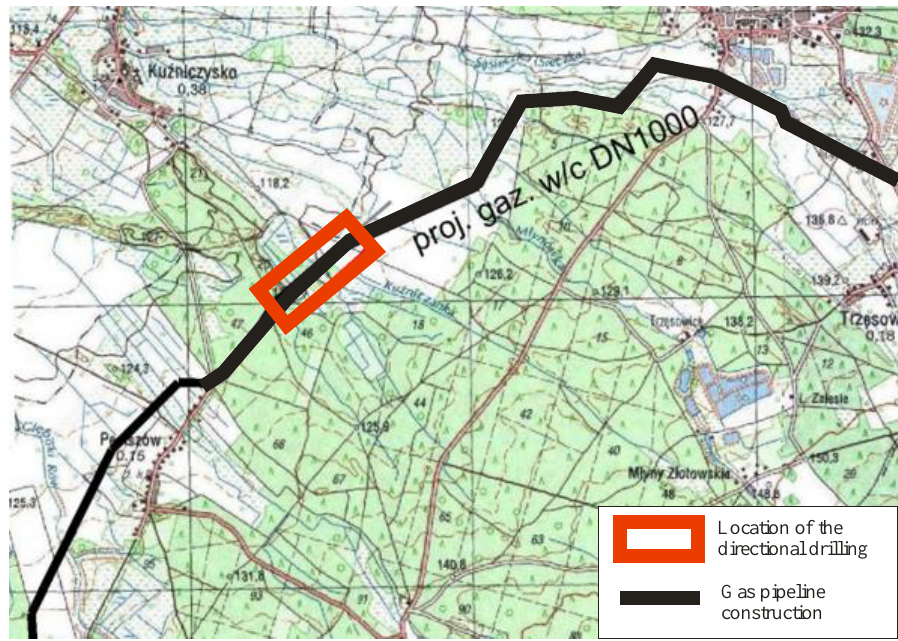
Figure 1. Location of the directional drilling HDD on the route of the gas pipeline construction.